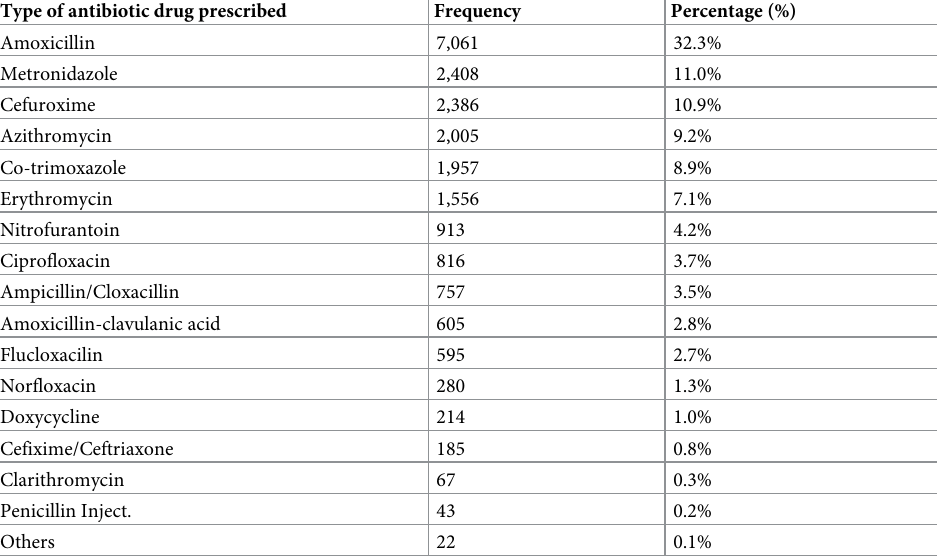
Table 5. Ranking the frequency of antibiotic drugs prescribed at the study clinics between April 1 and December 27, 2016, in Nairobi, Kenya (N =